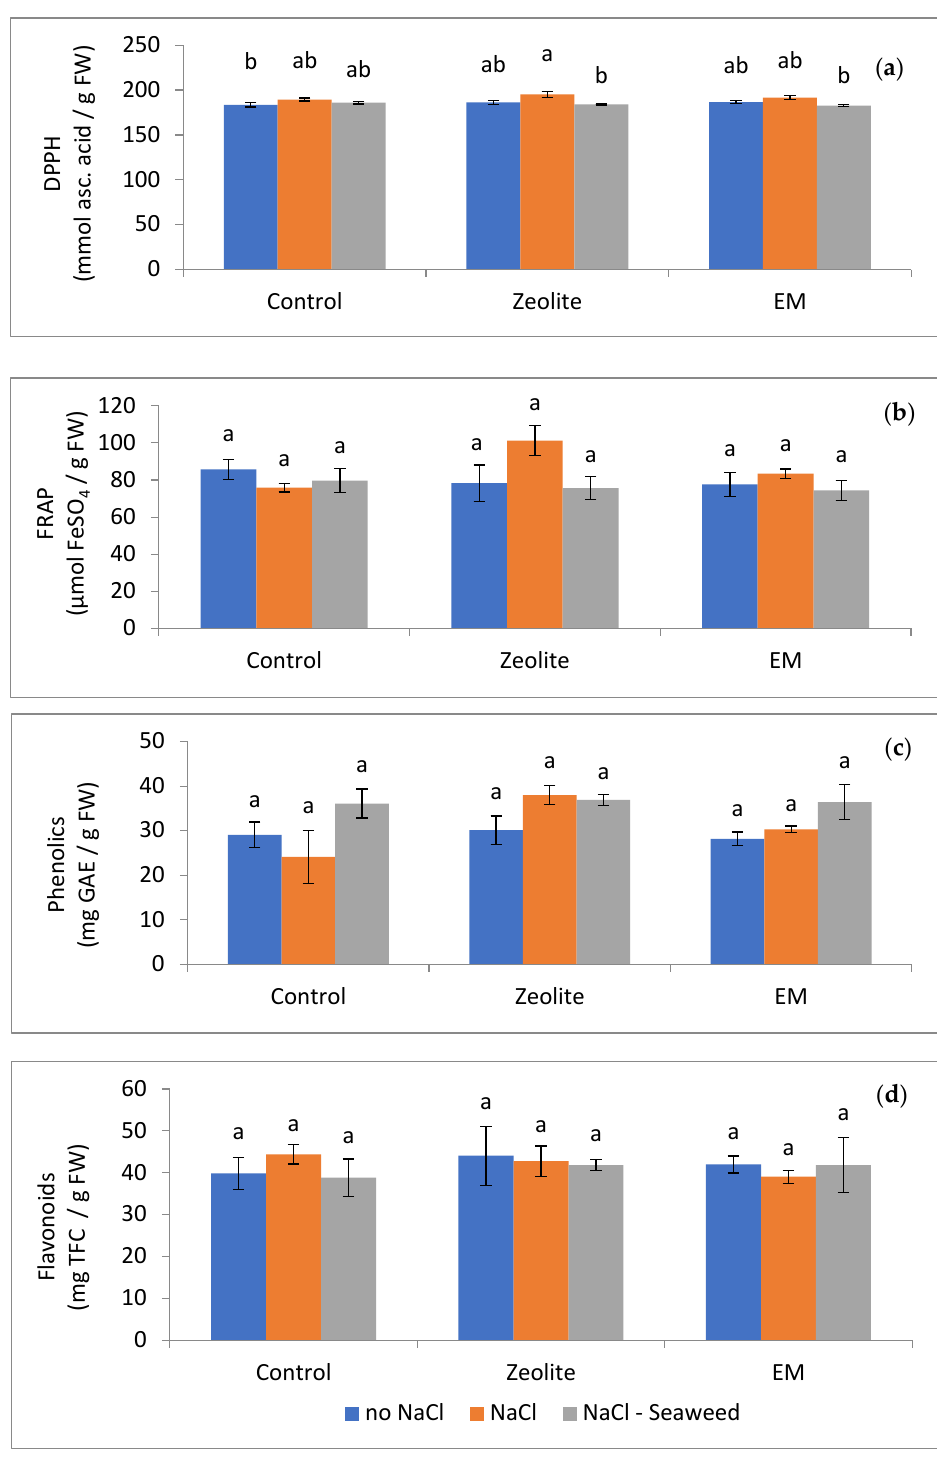
Figure 2. ( a ) DDPH, ( b ) FRAP, ( c ) phenolic compounds, and ( d ) flavonoid concentration in leaves of the apple plants. All the values are averages of three replications ± standard error. The different letters in the same column show statistically significant differences among the nine subtreatments, according to the Tukey test ( p ≤ 0.05) with the larger values corresponding to the letter “a”. I: no NaCl, II: NaCl 50 mM, III: NaCl 50 mM + seaweed extract spraying. EM treatment included compost addition.